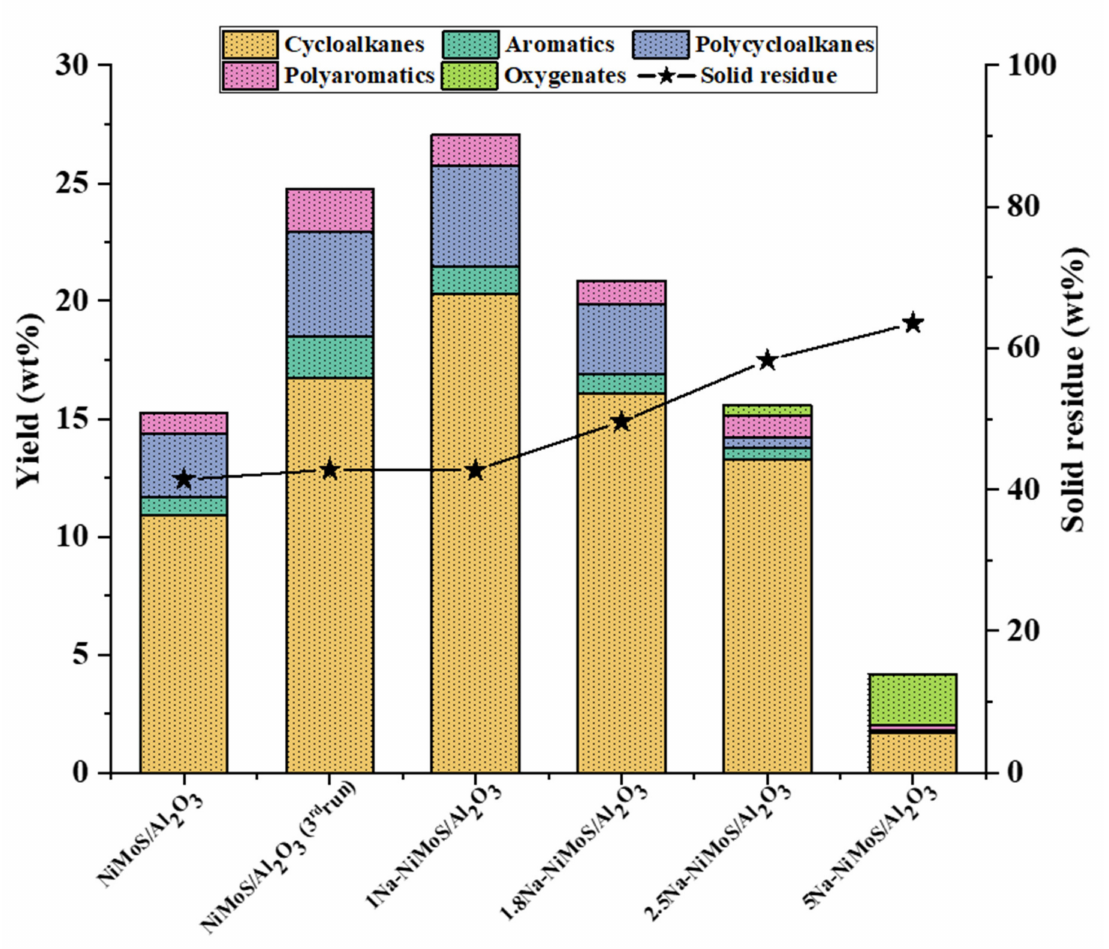
Figure 2. Product yield and solid residue obtained over NiMoS/Al 2 O 3 containing different amounts of